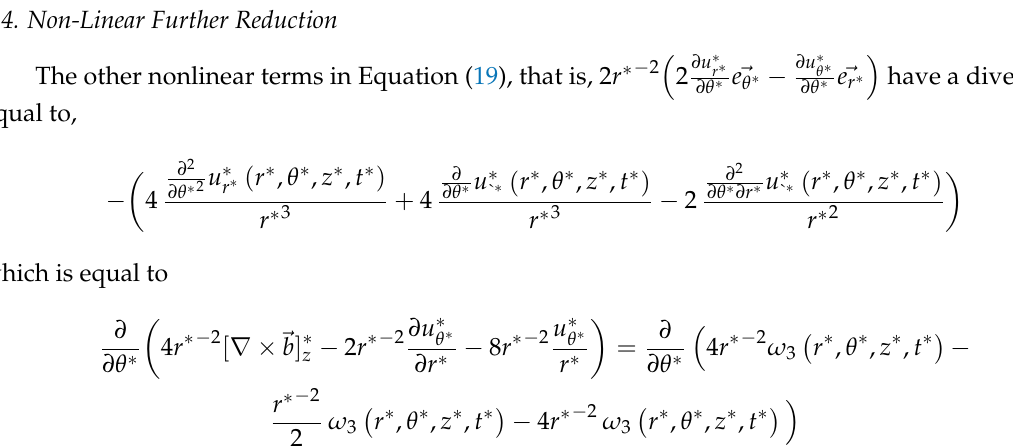
Figure 3. A cylinder in green with embedded surface r = 2019